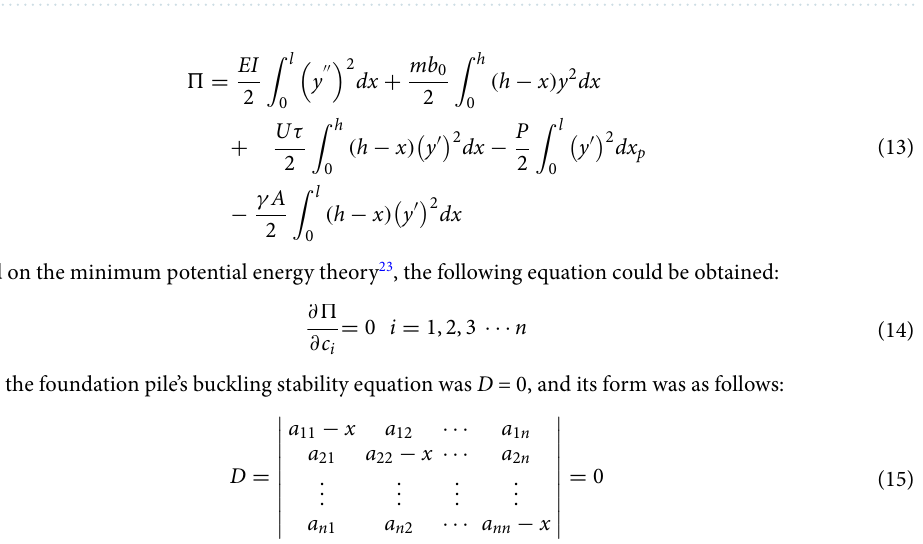
Figure 6. Influence of half-wave number on the critical load at different excavation